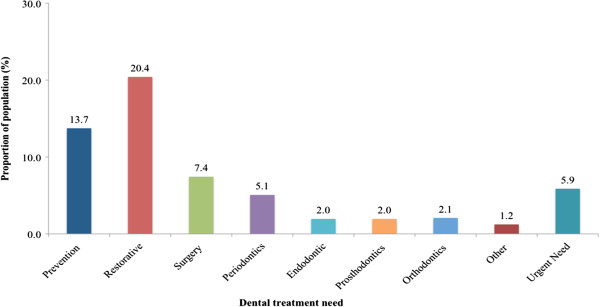
Percent of type of dental treatment required in the Canadian population.